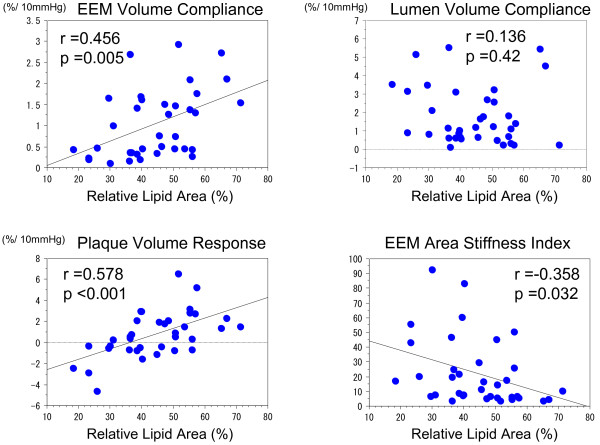
 Correlation among relative lipid volume, mechanical properties and plaque behavior in the less calcified group. The EEM volume compliance, plaque volume compliance and EEM area stiffness index were significantly correlated with relative lipid area whereas there was no significant correlation between lumen volume compliance and relative lipid area. EEM: external elastic membrane.